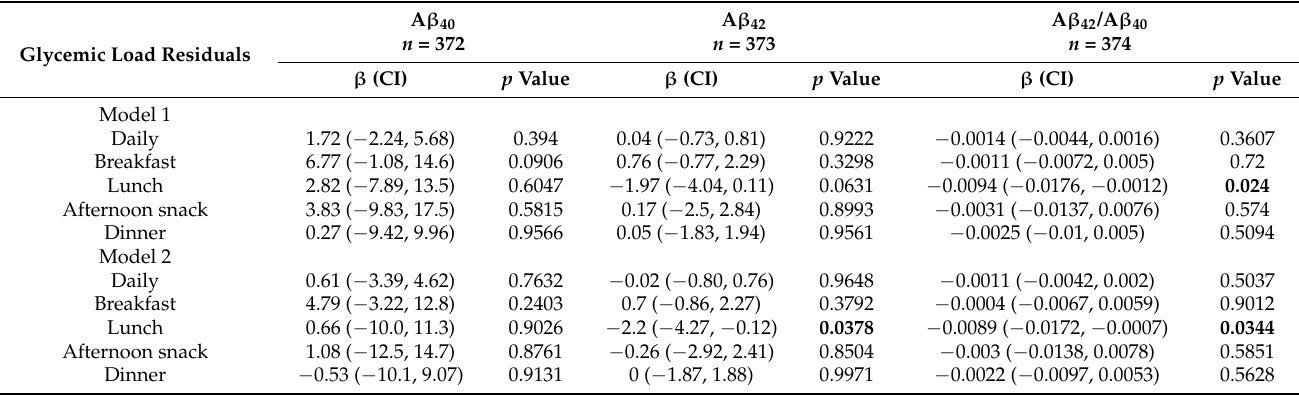
Table 2. Association between glycemic load residuals and amyloid- β peptides.